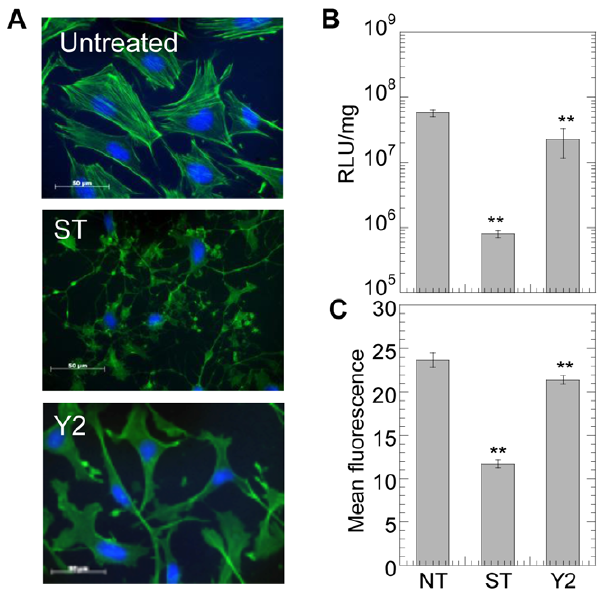
Figure 7. PKC and ROCK inhibition, inhibit gene transfer in cells plated on fibronectin. mMSCs were cultured for 16 hours on fibronectin coated plates prior to treatment with 10 m M Y27632 (Y2) or 100 nM Staurosporine (ST) for 2 hours to inhibit ROCK and PKC, respectively. ( A ) Changes in mMSC cell morphology were visualized through staining for actin using Alexa488 conjugated phalloidin and for DNA using Hoechst 33258 dye. Images were taken with a Zeiss AxioObserver Z1 inverted microscope at 40 6 magnification. Immedi- ately after treatment with inhibitor, the medium was replaced and bolus transfection was done. ( B ) Transgene expression was analyzed 48 hours post transfection using luciferase assay and normalized with total protein analyzed using Peirce BCA assay. Internalization was assessed 2 hours post transfection using flow cytometry and YOYO-1 labeled polyplexes ( C ). A total of 7000 events were analyzed per sample. Statistical analysis was done using a one-way Anova followed by the Dunnett Multiple Comparison test. The Anova p value was 0.0003 and , 0.0001 for transgene expression and internalization, respectively. The symbols ** represents a significant change to the level of p , 0.01.